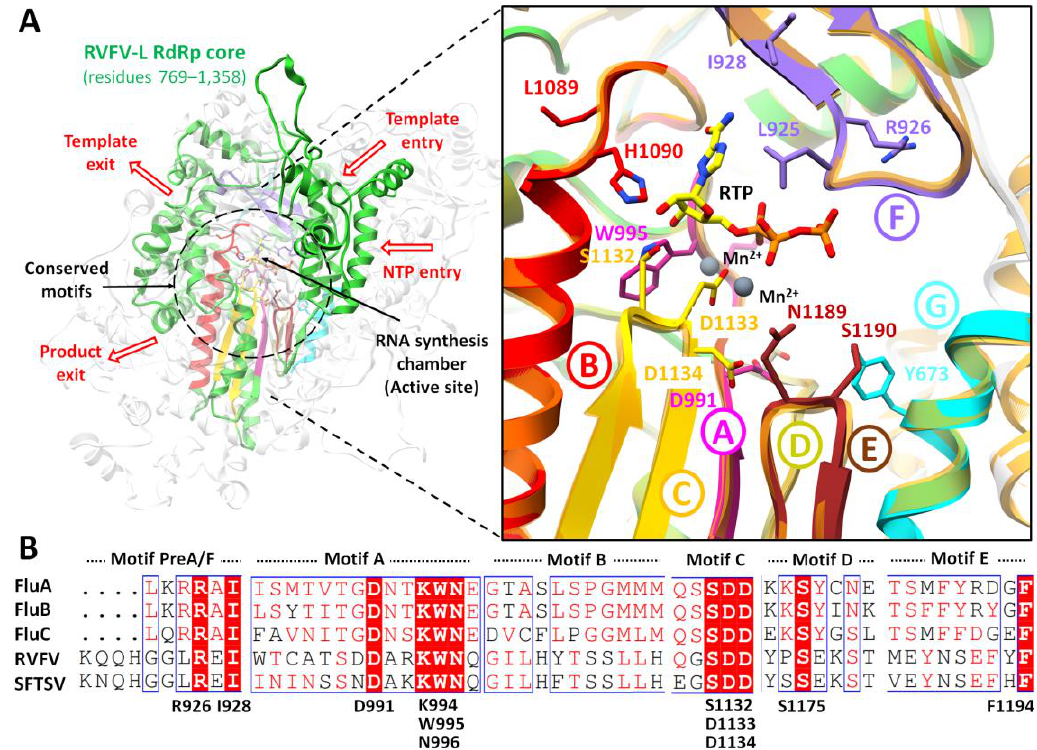
Figure 2. The predicted RVFV-L RdRp active site. ( A ) The RVFV-L RdRp core (residues 769–1358) is highlighted in green with conserved RNA synthesis chamber (active site), organized by conserved structural motifs in distinct colors. The four predicted tunnels are marked with arrows as an entrance (template and NTP entry) into the active site chamber and exit tunnels (template and product exit). The arrangement of structurally conserved RdRp motifs are colored magenta, red, golden, khaki, brown, purple, and cyan for motifs A–F, respectively, and superimposed on SFTSV-L RdRp core (light orange). ( B ) The predicted binding site residues are aligned and highlighted through multiple structure alignment (MSA) in representative motifs. These conserved residues are highlighted in stick representation accordingly. Superposition of the poliovirus elongation complex structure (PDB ID: 3OL8) and foot-and-mouth disease virus in complex with RTP (PDB ID: 2E9R) displays the conformation of RTP (yellow) and positions of the catalytic divalent cations (black spheres). Viral names in MSA are abbreviated as follows: Influenza A (FluA), B (FluB), and C (FluC) virus polymerase, Rift valley fever virus (RVFV), and Severe fever with thrombocytopenia syndrome virus (SFTSV).